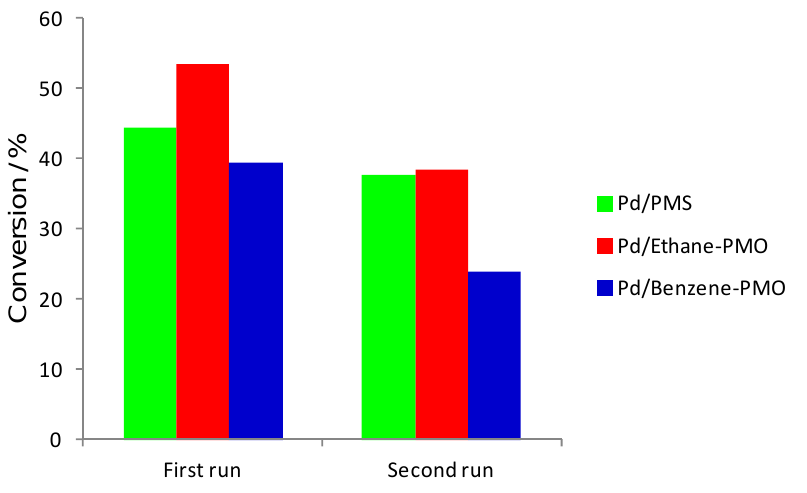
Figure 6. Overall conversion at 24 h in the Suzuki coupling of bromobenzene with phenylboronic acid on Pd-supported mesoporous materials in two consecutive runs.